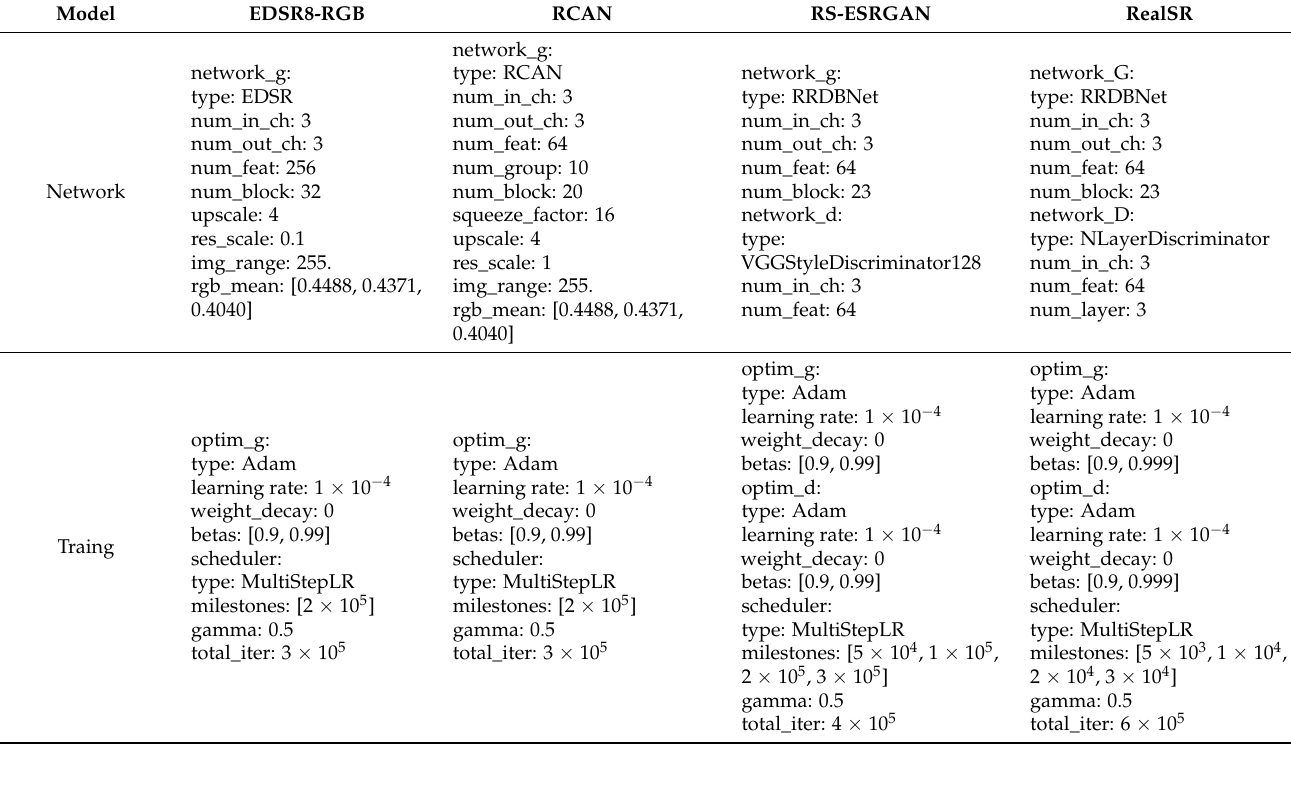
Table 2. Settings of specific parameters for the models implemented in the framework of BasicSR.